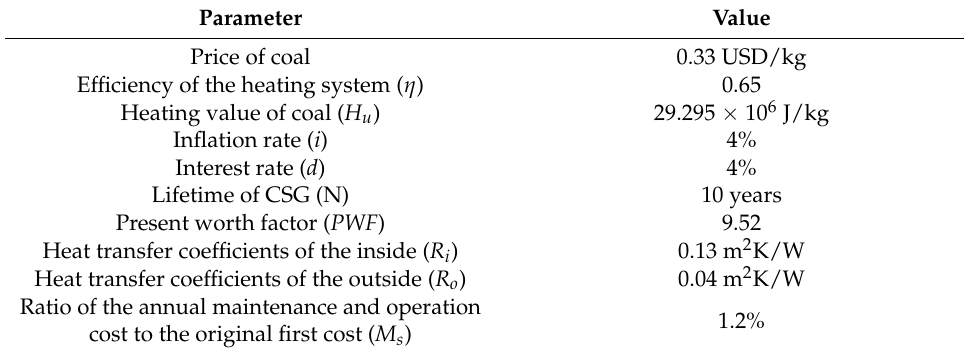
Table 3. The parameters used in